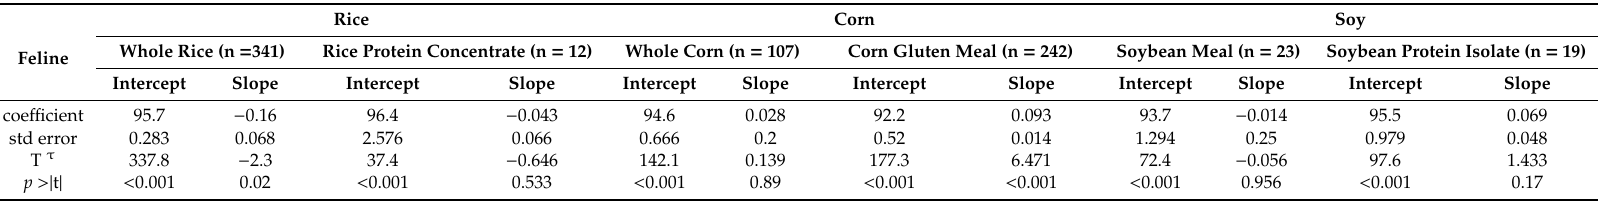
Table 7. Relationship between true protein digestibility and the amount of the dietary protein contributed by whole grains or protein fractions (expressed as dry matter) in feline